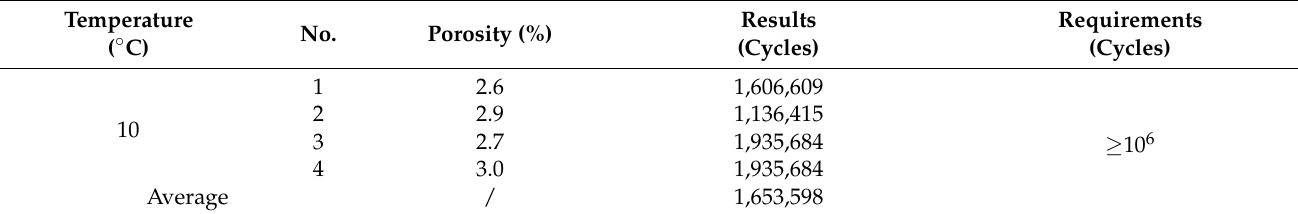
Table 10. Results of the fatigue performance test.